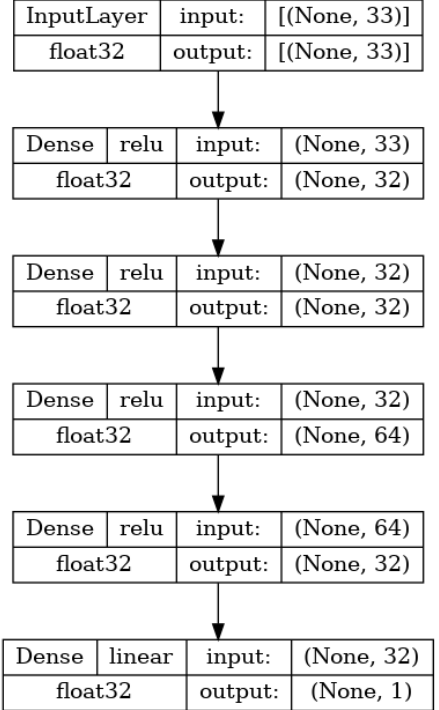
Figure 3. Architecture of the molecule property-based regression